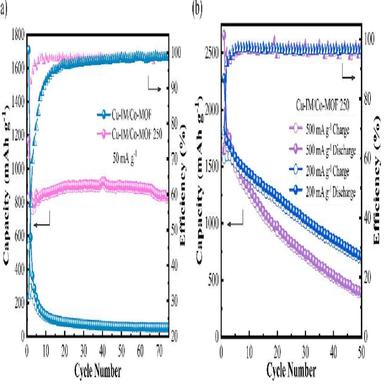
Cycle performance of (a) Cu-IM/Co-MOF 250 and Cu-IM/Co-MOF electrode at 50 mA g− 1 , (b)Cu-IM/Co-MOF 250 electrode at 200 and 500 mA g− 1 .